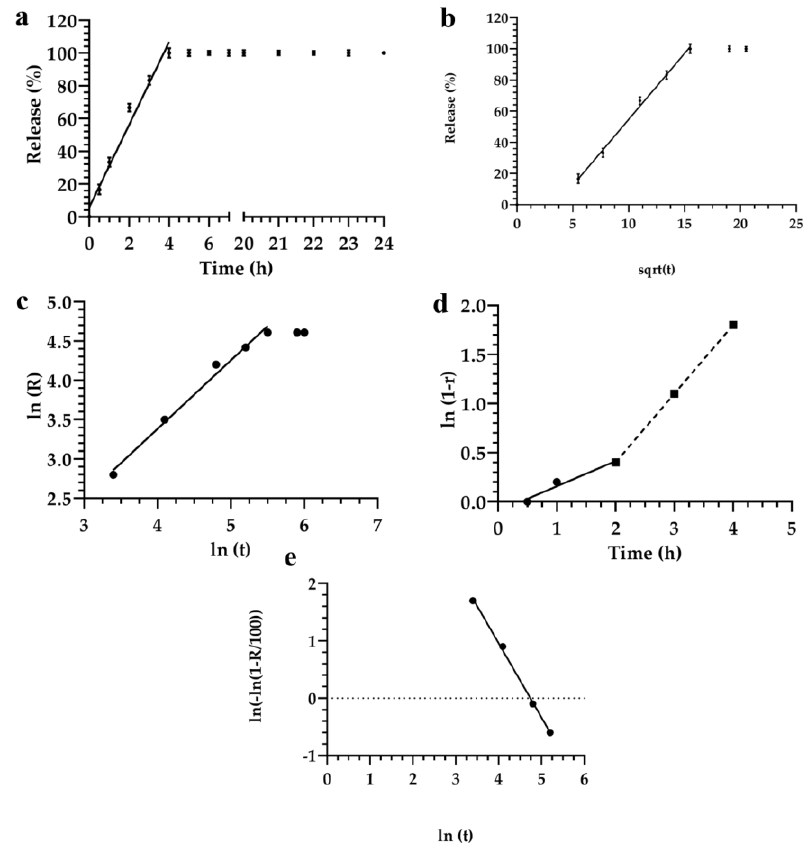
Figure 2. Release kinetic of fluorescein from the lyotropic colloidal liquid crystal formulation 1,